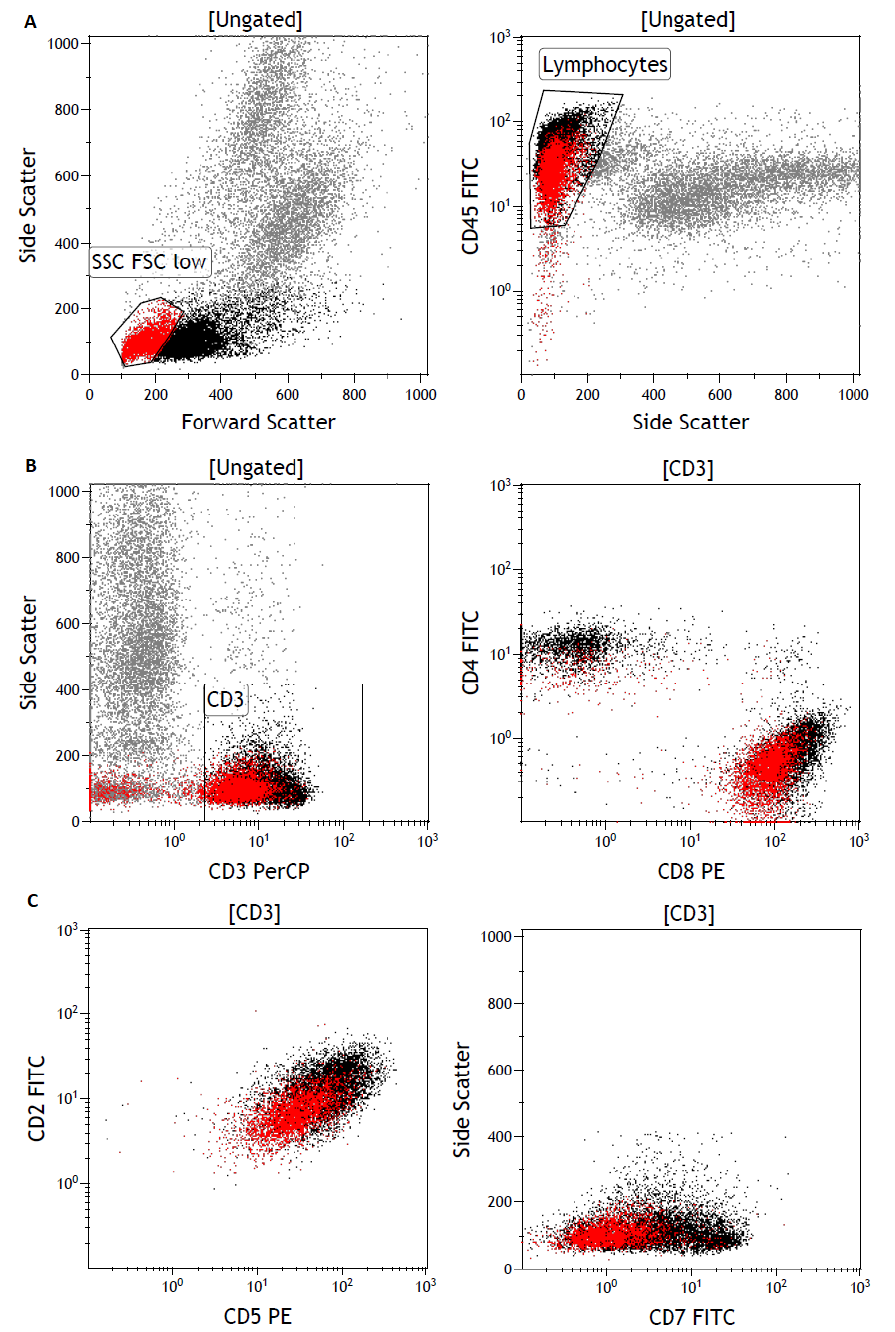
Figure 1. Gating strategy for the characteristic aberrant T-cell population. ( A ) Forward scatter versus side scatter gating identifies small aberrant cells indicated in red (left) with low CD45 expression (right). ( B ) The aberrant T-cells are CD3-positive (left). Plotting of CD4 versus CD8 highlights the lower expression of CD8 in these aberrant T-cells (right). ( C ) Diminished CD2 and CD5 marker expression on the small aberrant T-cell fraction (left); side scatter versus CD7 plotting demonstrates lack of / weak expression of CD7